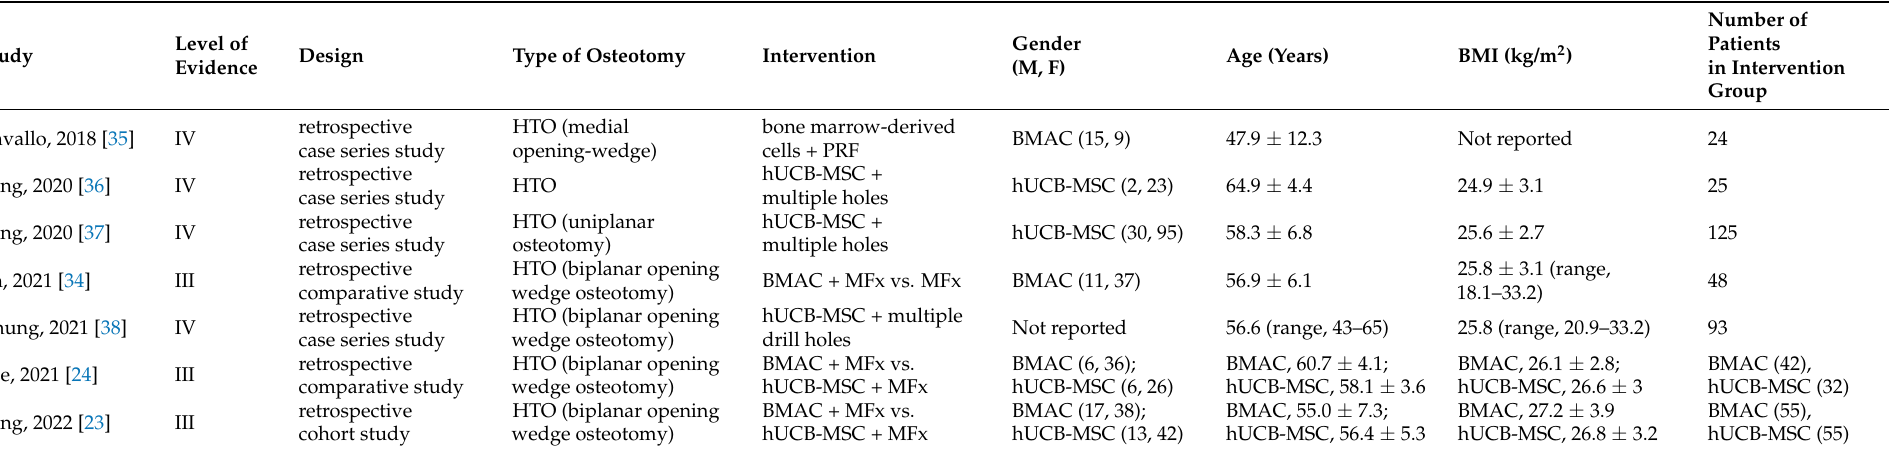
Table 1. Characteristics of the included